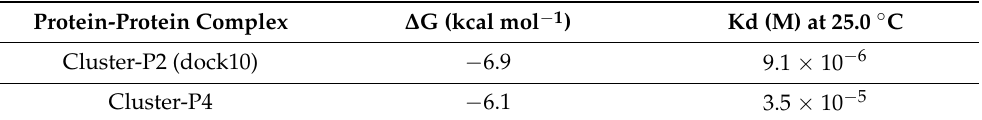
Table 8. Binding energy and Dissociation constant of the first cluster formed after 20 ns MD simula-